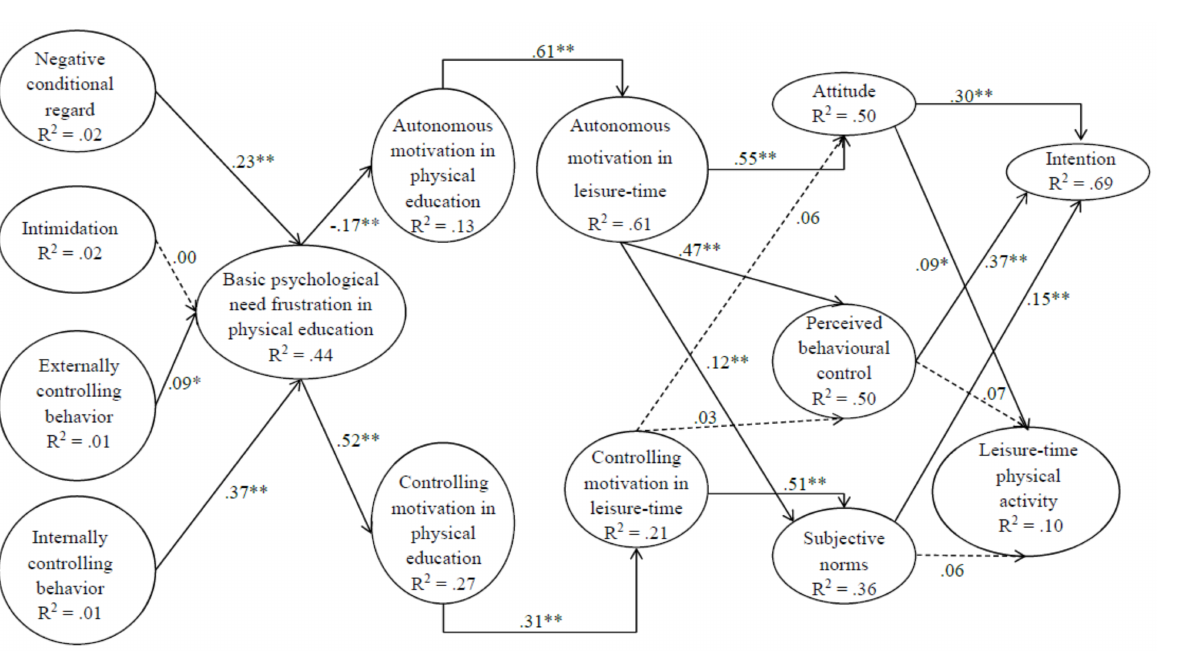
Figure 1. Structural model results. Note: For clarity, the effect of previous physical activity is excluded from the figure, although it is taken into account in the model; statistically significant direct correlations are shown in the figure with a solid line, and statistically non-significant direct correlations are represented with a dotted line; R 2 = described variance; ** p ≤ 0.01. Table 4. Relationships between study